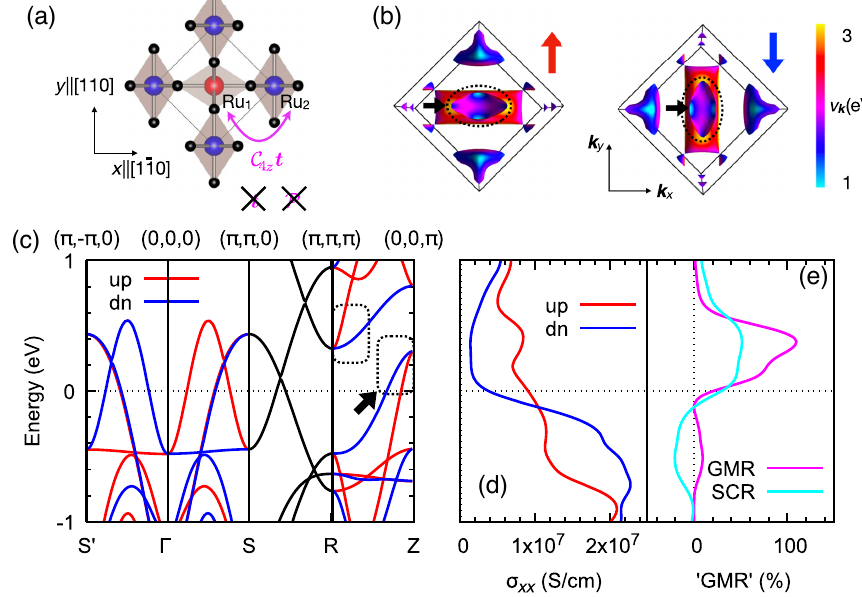
FIG. 3. First-principles calculations of GMR in RuO 2 [32]. (a) Crystal structure of RuO 2 . Red and blue mark opposite magnetic moments on the first and second Ru sublattices. The presence of an intersublattice transposing symmetry containing a crystal rotation operation ( C 4 z ) and the absence of translation ( t ) and inversion ( P ) transposing symmetries are also highlighted. (b) Fermi surface plots for spin-up (left) and spin-down (right) states. The color coding corresponds to the group velocities, highlighting the strong anisotropy of the two spin-channel conductivities. (c) Spin-projected nonrelativistic energy bands of RuO 2 with marked anisotropic spin-momentum coupling around R and Z points. (d) Longitudinal spin-up and spin-down conductivities. (e) GMR ratio. For comparison, also shown is the transverse spin current relative to the longitudinal charge current (SCR) calculated in Ref. [37].